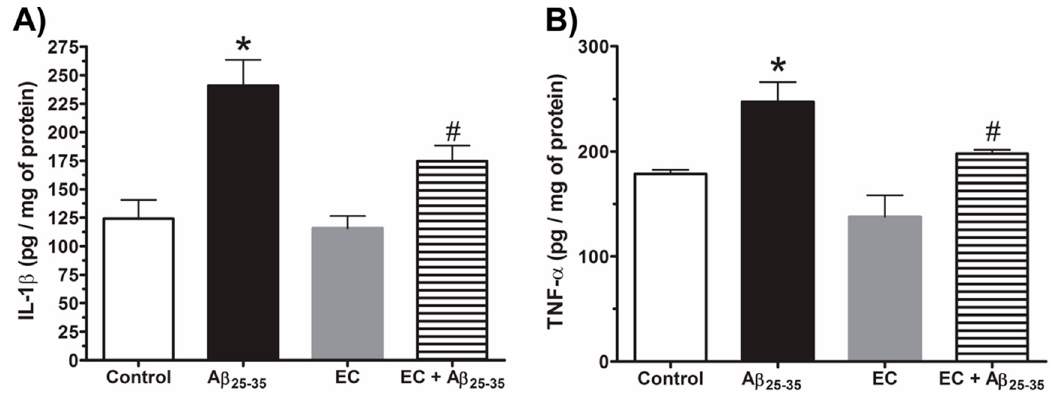
Figure 3. The epicatechin treatment decreases the concentration of proinflammatory cytokines in Hp of rats with A β 25–35 . ( A ) IL-1 β in Hp and ( B ) TNF- α in Hp. The mean ± SE is plotted. Data were analyzed with one-way ANOVA and post-test Bonferroni test (* p < 0.05) comparing all groups with respect to the vehicle group. # p < 0.05 compared the A β 25–35 group versus EC + A β 25–35 group.